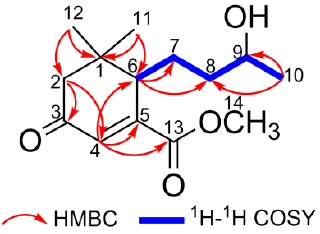
Figure 2. Key HMBC and 1 H- 1 H COSY correlations of compound 1 .